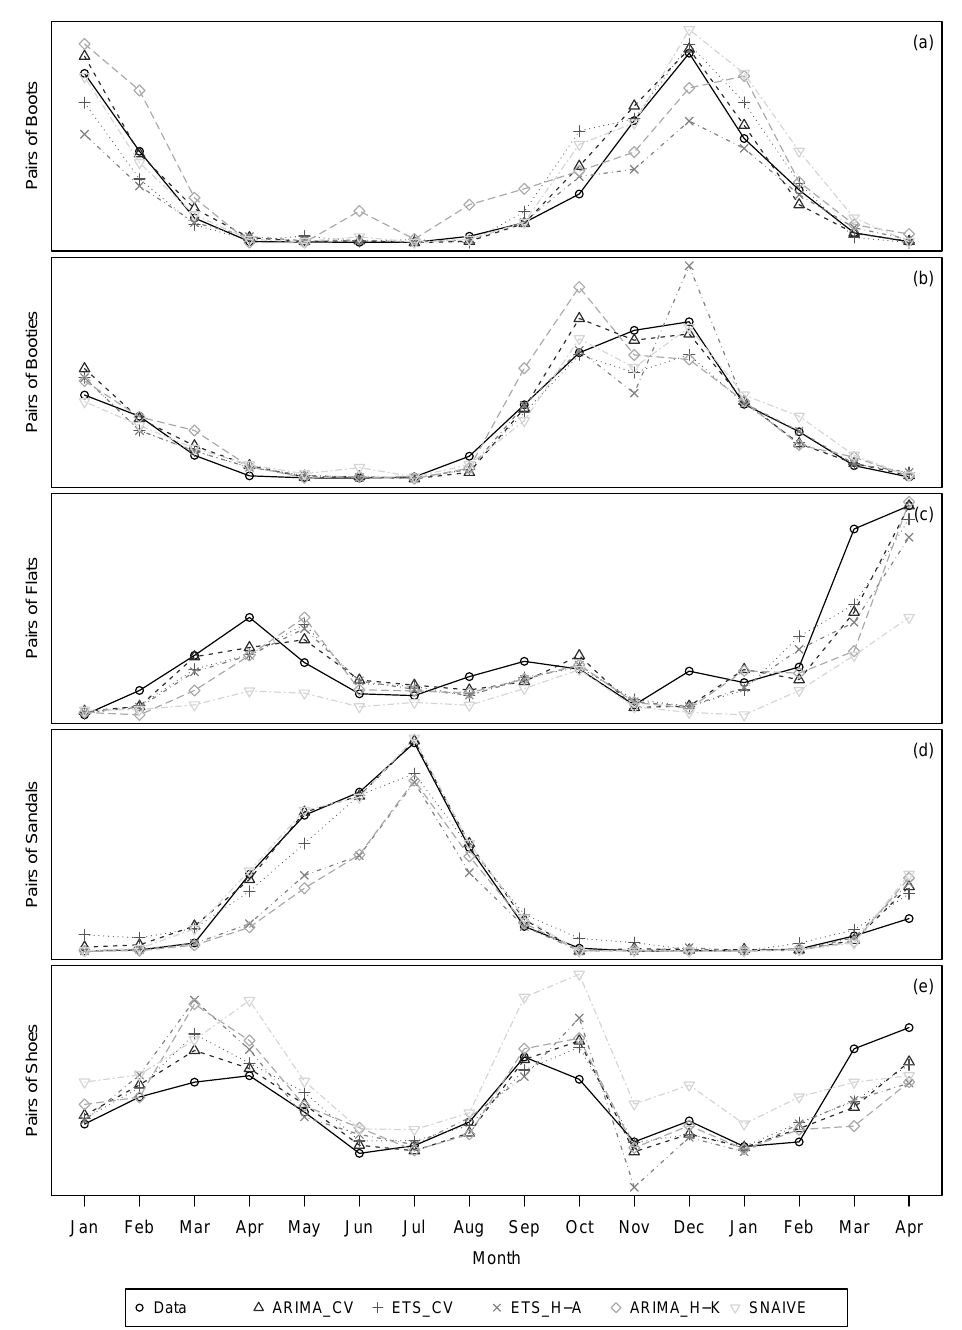
Figure 3. One-step forecasts from all approaches computed using time series cross-validation (January 2011 to April 2012): ( a ) pairs of Boots; ( b ) pairs of Booties; ( c ) pairs of Flats; ( d ) pairs of Sandals; and ( e ) pairs of